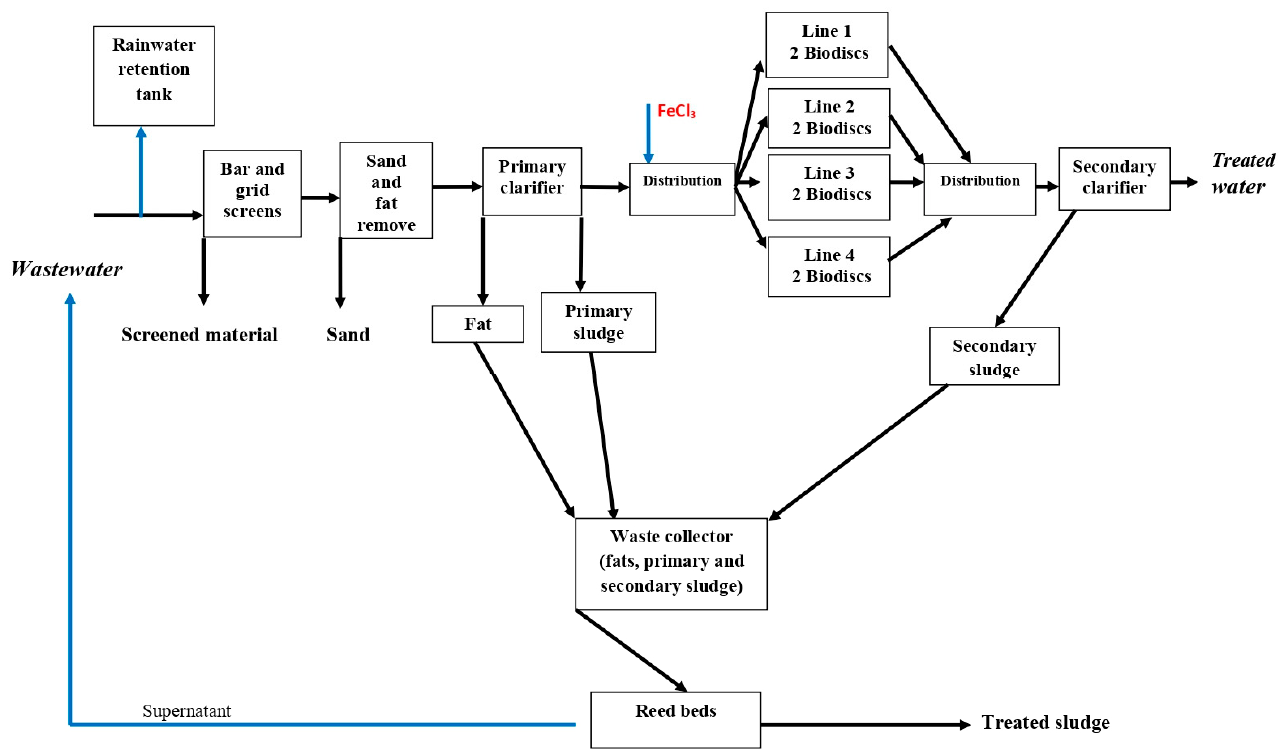
Figure 1. Flowchart of the Agnita WWTP.